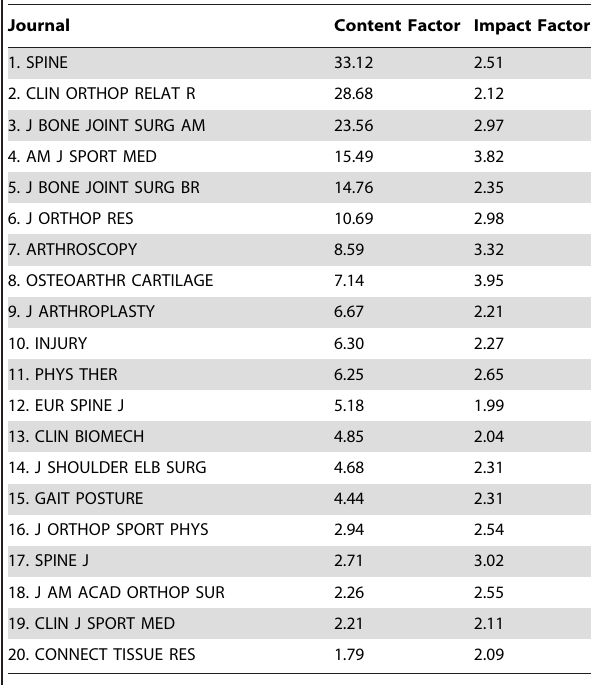
Table 2. Content and Impact Factors for the